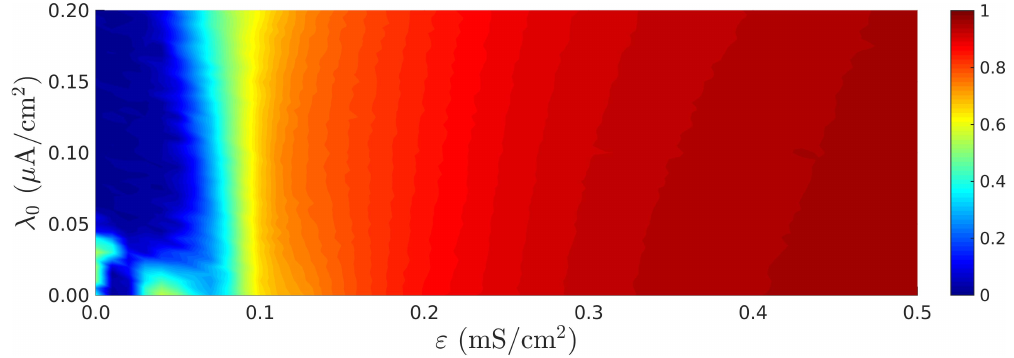
Figure 4. (cid:104) R (cid:105) as functions of ε and the amplitude of the external pulsed current λ 0 , for a high frequency ν = 140 Hz. For amplitudes λ 0 ≥ 0.05, the method successfully suppressed the anomalous synchronization occurring for coupling strength ε (cid:46) 0.007..